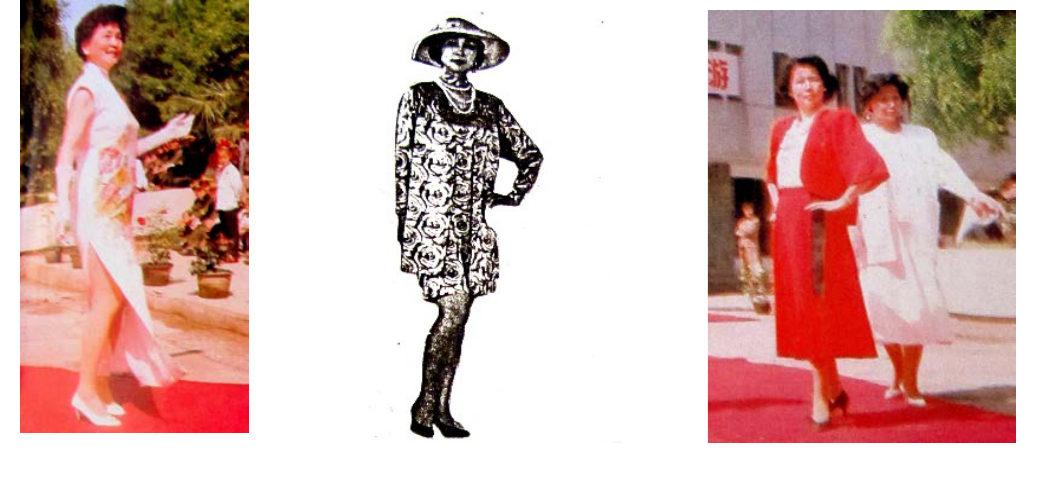
Figs.4-7: 1990’s Chinese Magazine Photos of Middle Aged and Elderly Fashion. Traditional Chinese qipao (far left) Photo: Paiji Li, 1991; “Western-style” upscale dress (middle) Photo: Ying Xiao, 1990; Western suit sets and bold color (right) Photo: Peiji Li,